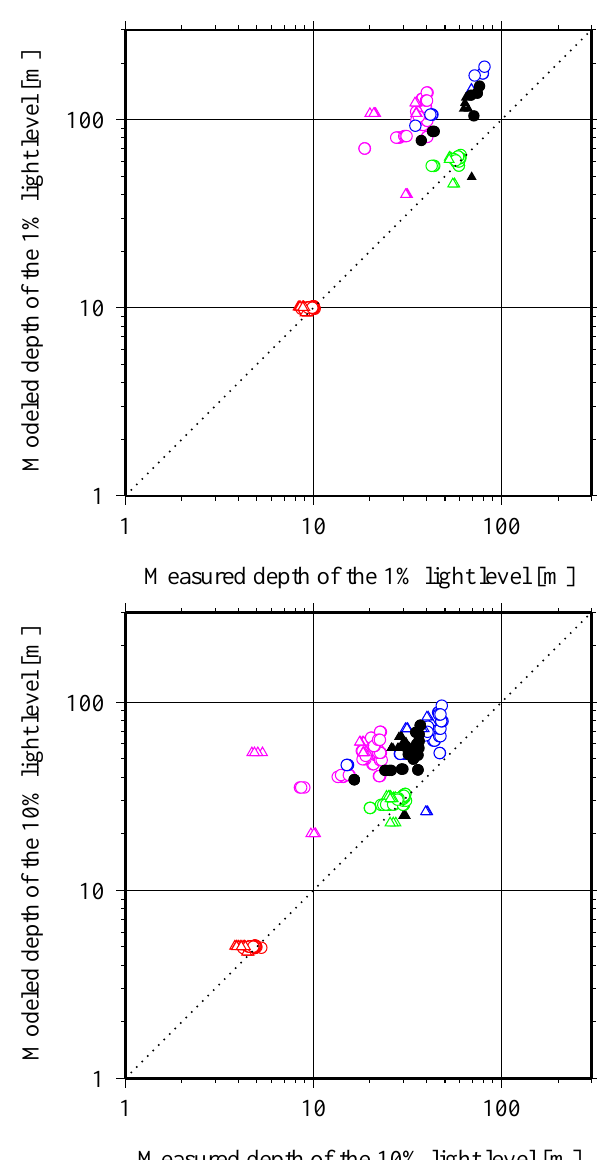
Fig. 13. Predicted (MM01) versus measured depth of the 1% (top) and 10% (bottom) light levels. Symbols are as for previous figures, i.e., circles for open-ocean stations and triangles for ice-edge sta- tions. Pink, blue, green, red, and black symbols are for λ = 380, 443, 555, 670nm and PAR,